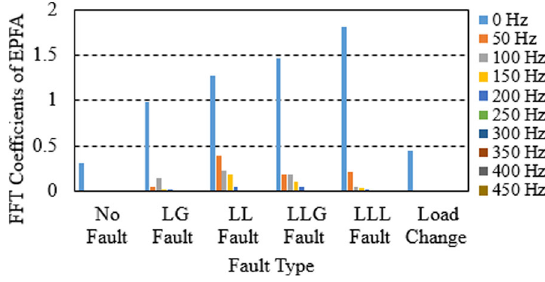
Fig. 4 FFT spectra of EPFA variation shown in Fig. 3(a)